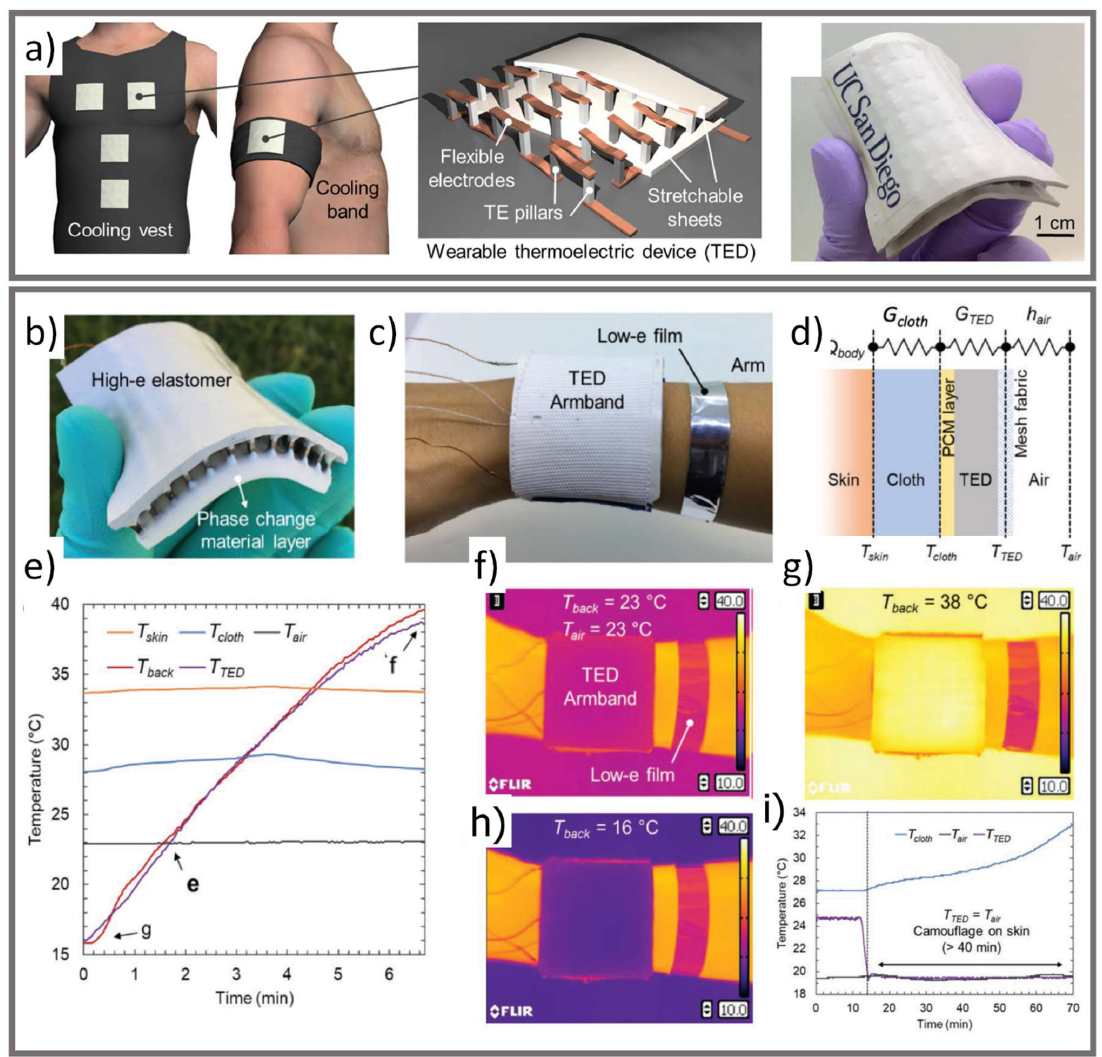
Figure 9. ( a ) Schematic of cooling vest with wearable TEDs patches (reproduced from [62], under CC BY-NC 4.0). ( b ) Flexible PCM/TED, ( c ) worn as an arm band, ( d ) corresponding thermal resistance circuit, ( e ) variation of the temperature as a function of time, ( f – h ) IR images of the band recorded at 23 °C, 38 °C, and 16 °C, respectively, ( i ) camouflage effect of the TED on the skin over time (reproduced from [19] with permission from John Wiley and Sons).